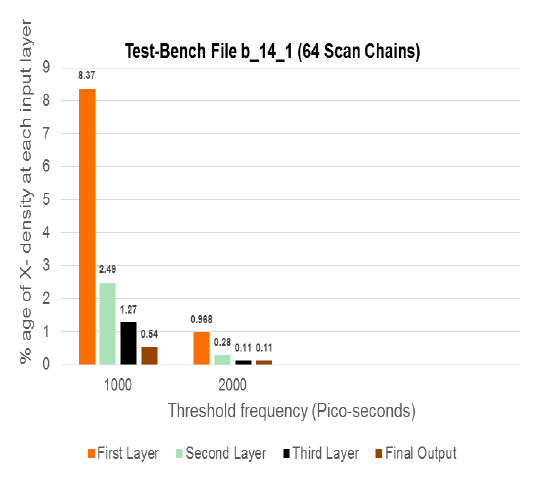
FIG. 7: TEST BENCH FILE B14_(64 SCAN CHAINS)